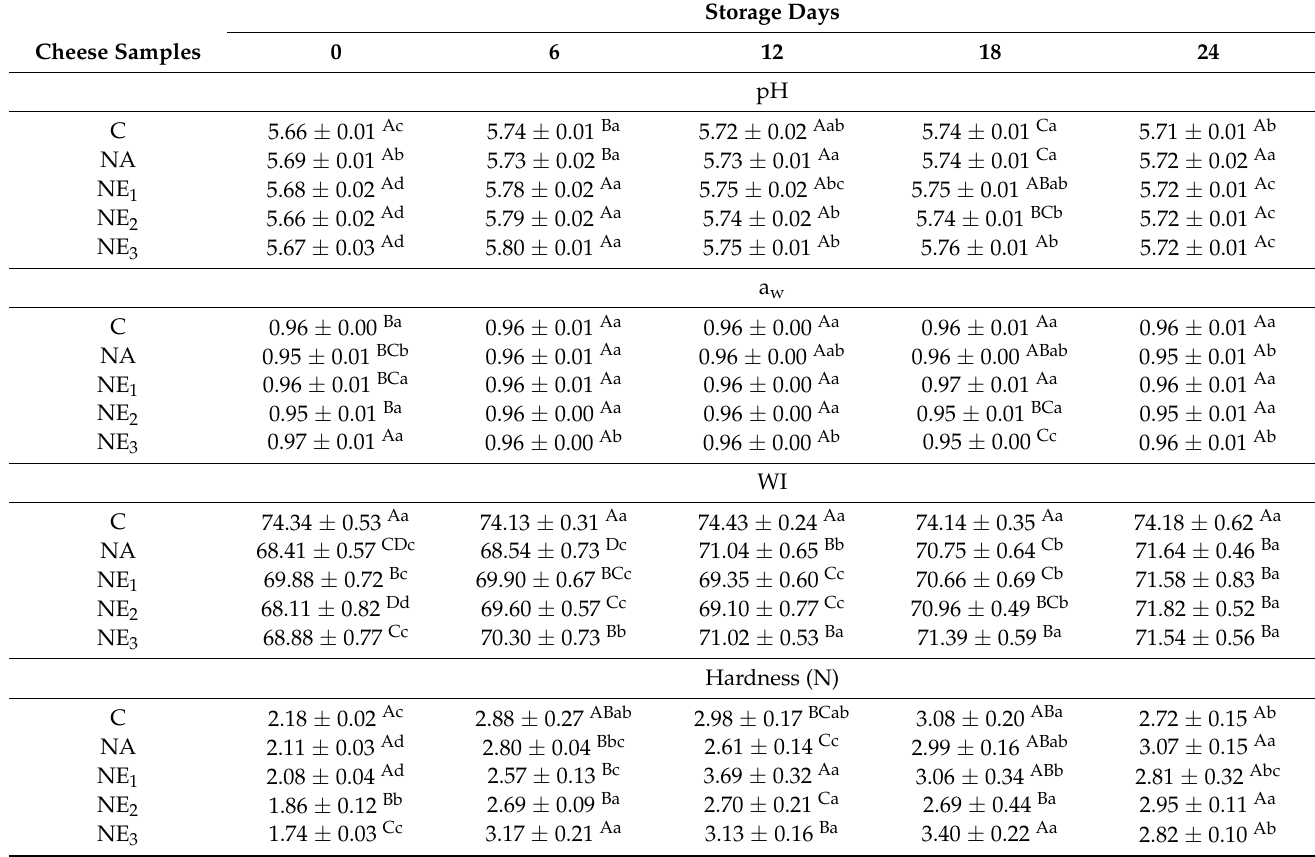
Table 4. The effect of nanoemulsion coating on the physicochemical properties of the cheese samples. Storage